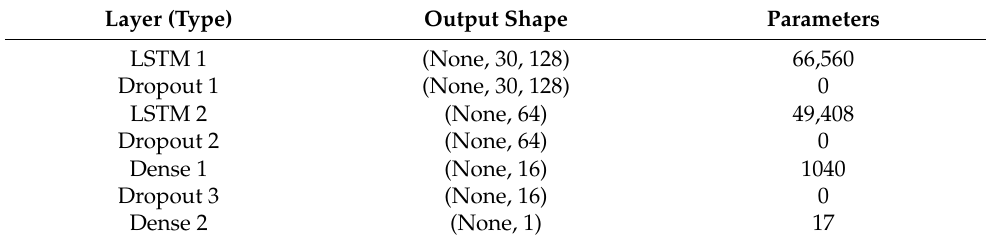
Table 5. The validation LSTM model summary.